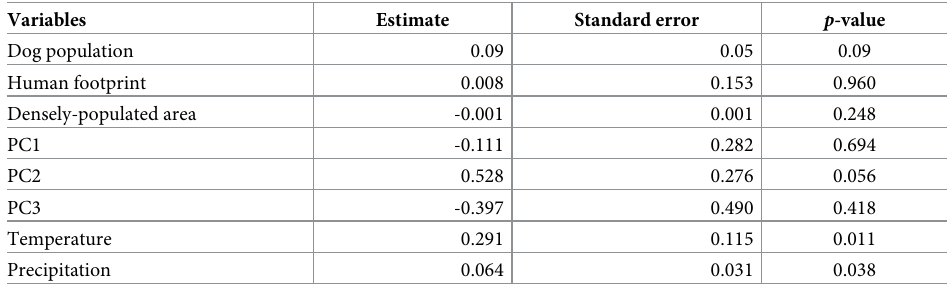
Table 7. Univariable analysis results for dog rabies cases in South Africa between 2008 and 2012 excluding the Kruger National Park.